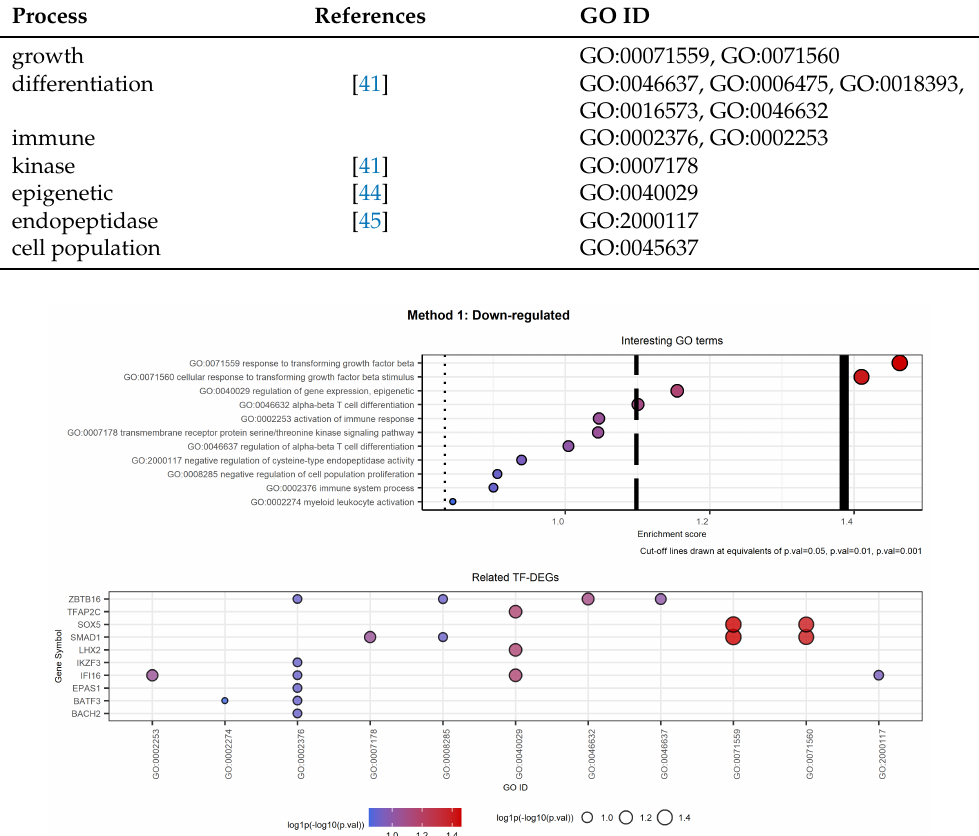
Table 4. GO terms of the biological processes selected by Method 1 for down-regulated genes. We note that most of the GO labels are associated with the term differentiation. Moreover, the other terms comprised in the selection also appear to be clearly correlated with CML.